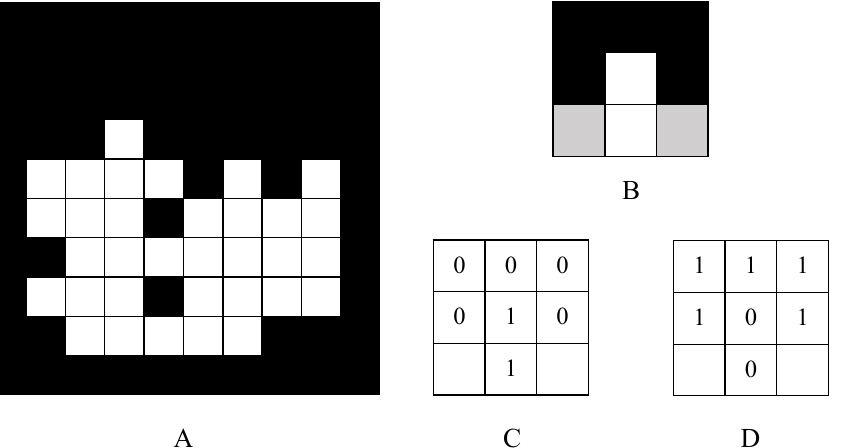
Figure 9. Hit-or-miss transform. ( A ) Original region needs to be improved; ( B ) structure element; ( C ) denotes each pixel value of B; ( D ) complement set of B.